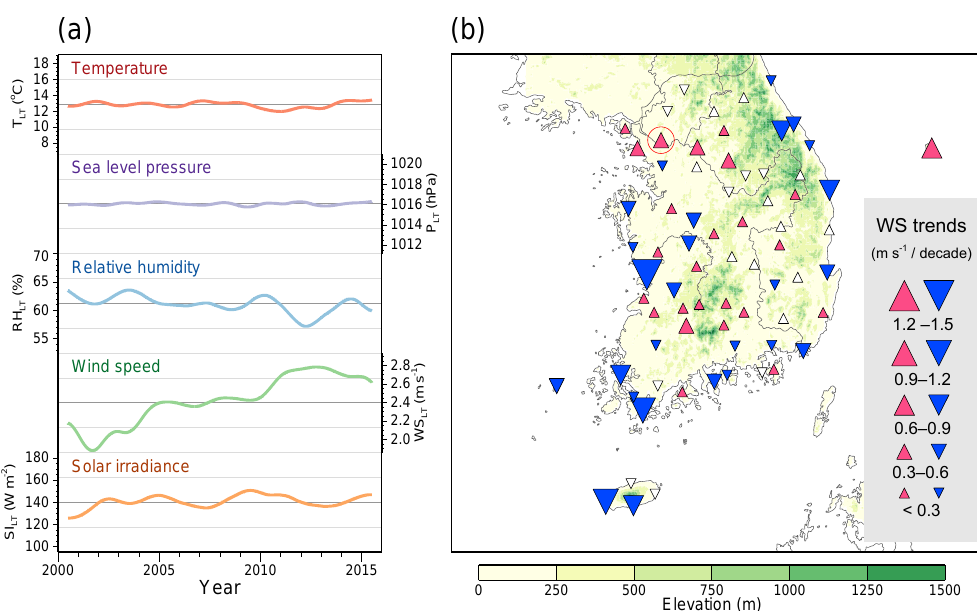
Figure 6. (a) Long-term components of daily average temperature, sea level pressure, relative humidity, wind speed, and solar irradiance. Vertical scales represented by gray horizontal lines are equivalent to 0.3 standard deviation of each original time series of the meteorological variables. (b) Linear trends of wind speed observed at 75 weather stations over South Korea for the period of 1999–2016. Upward and down- ward triangles with colors indicate the increasing and decreasing trends which are statistically significant at or above the 95% confidence level ( p <0.05), respectively. Location of Seoul is marked by a red open circle.